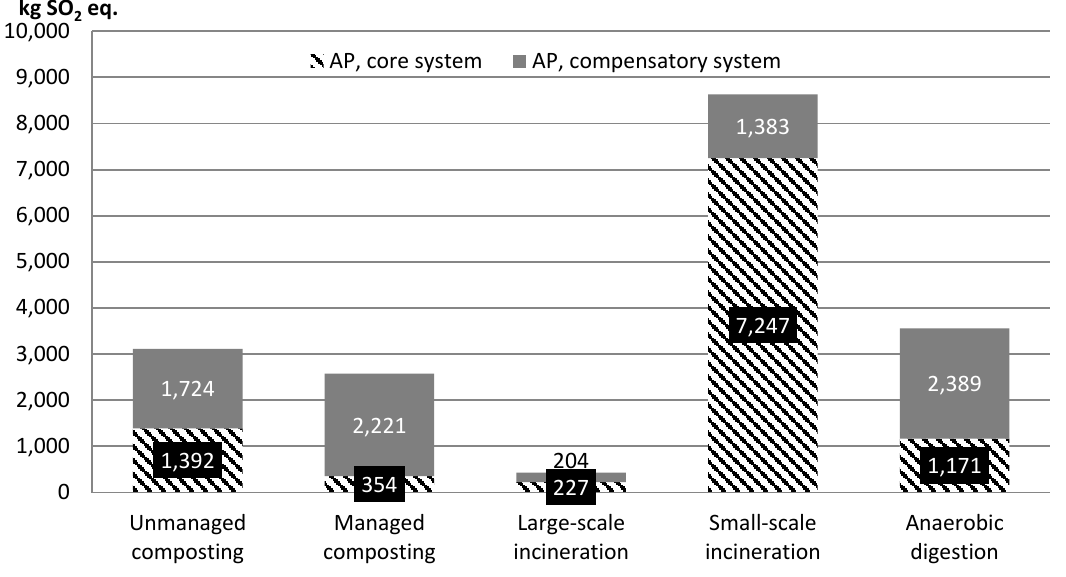
Figure 4. Acidification potential (AP) in simulated scenarios.